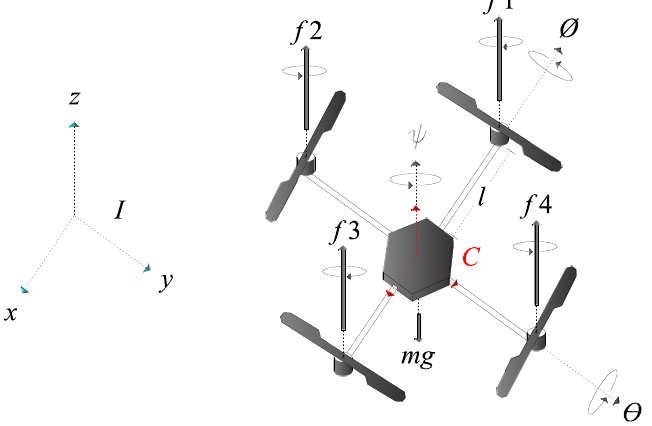
Figure 1. Quadrotor kinematics and frames of